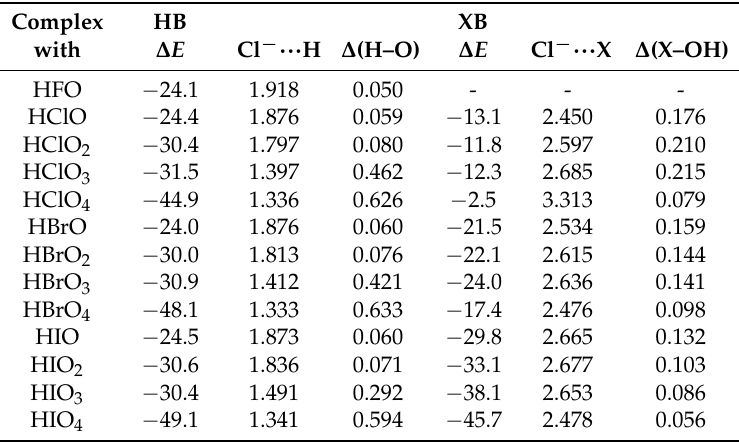
Table 4. The interaction energies ( ∆ E in kcal · mol − 1 ) and interatomic distances (Å) of the hydrogen bonding (HB) and halogen bonding (XB) complexes with Cl − . Complex HB XB